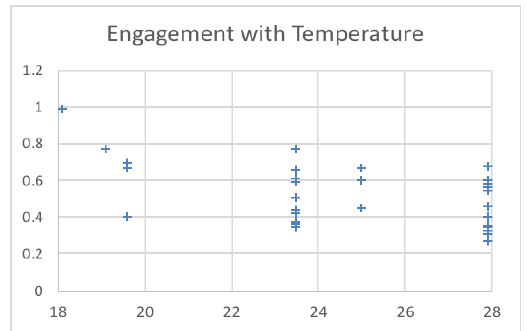
Figure 9. Engagement values for different temperatures.